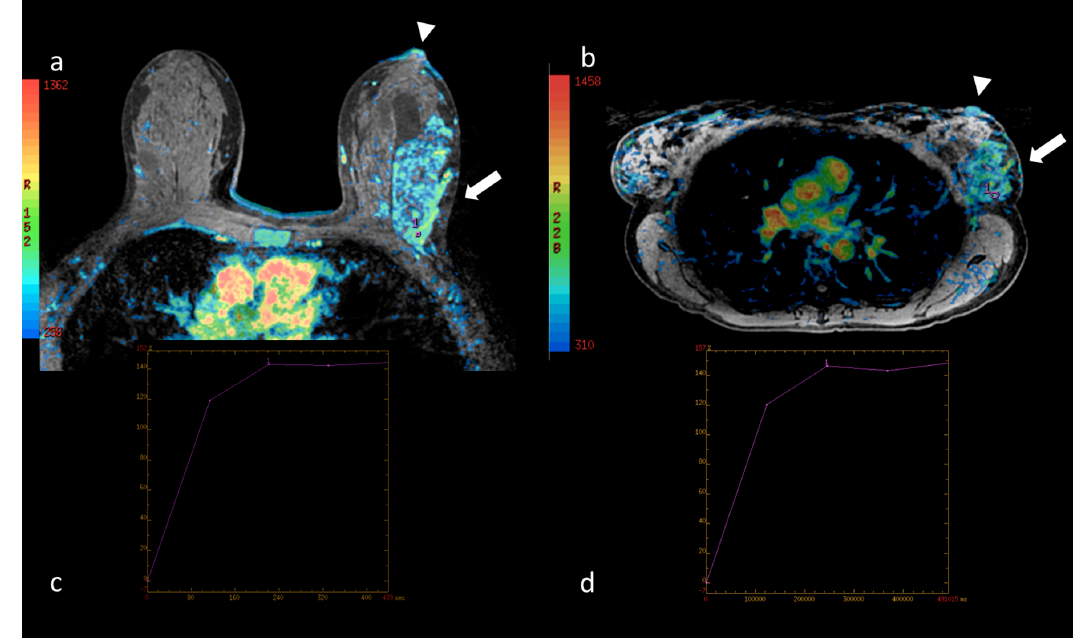
Figure 5. ( a ) Native image of the first dynamic sequence performed in the prone position superimposed with the colorimetric map showing maximum contrast impregnation (see the reference side bar) in the nipple area (arrowhead). At the confluence of the external quadrants of the left breast, the site of the neoplasia described in Figure 3, the distribution of the contrast medium is shown (arrow); in the area of maximum impregnation a region of interest (ROI) has been drawn marked by the number 1. The corresponding percentage/time intensity curve (au/sec, arbitrary units/second) is shown in ( c ). ( b ) Native image of the first dynamic sequence performed in the supine position superimposed with the colorimetric map. In this position, the dynamic curve of the breast lesion was evaluated in a ROI marked by the number 1. The corresponding percentage/time intensity curve (au/sec) is shown in ( d ). In both positions, the curve is a type I with the same maximum peak values in both the early and late phases, although the ROIs are of different sizes and positioned in different areas of the lesion.